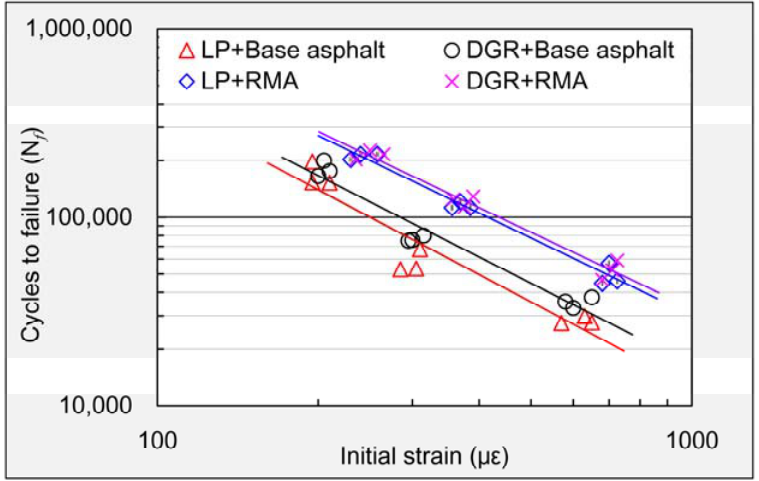
Figure 19. Regression analysis of obtained data points of fatigue life. Table 7. Fatigue equations of different asphalt mixtures.